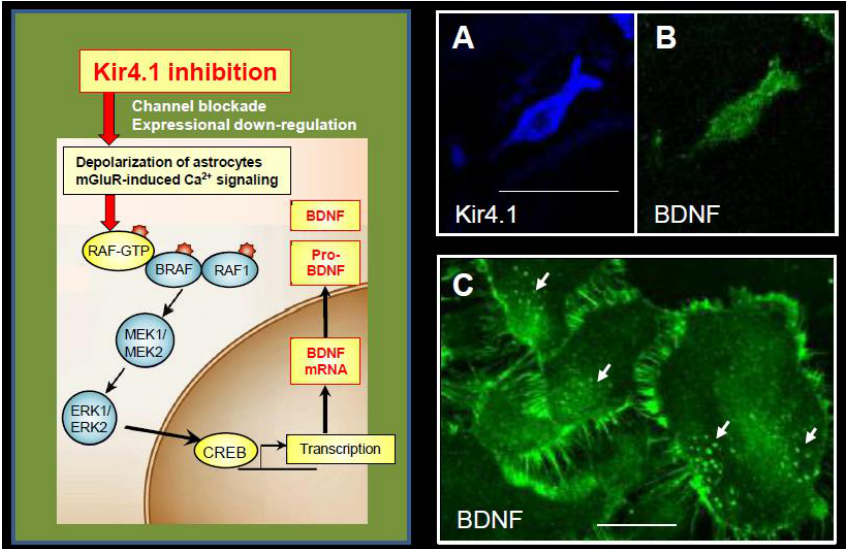
Figure 5. Mechanism underlying enhanced BDNF expression by Kir4.1 channels inhibition in astrocytes. Inhibition (channel blockade and expressional down-regulation) of Kir4.1 channels cause a depolarization of astrocytes (6,46) and/or activation of metabotropic glutamate receptors (mGluR) via elevating the [K + ] o and [Glu] o levels at synapses, respectively [46,47]. These events subsequently activate the Ras/Raf/MEK/ERK signaling pathway and enhance BDNF expression in astrocytes. The right photographs show co-expression of Kir4.1-immunoreactivity (IR) (blue: Alexa Fluor647) ( A ) and BDNF-IR (green: Alexa Fluor488) ( B ) in the same astrocyte. ( C ) Cultured astrocytes at a confluent stage contain many BDNF-containing secretary granules (arrows), where BDNF-IR spread from the soma to fine processes surrounding astrocytes, reflecting the secretary process of BDNF. Scale bar: 25 µ m ( A and B ) and 50 µ m ( C ). Photographs are quoted from Front. Mol. Neurosci . 2017, 10, 408